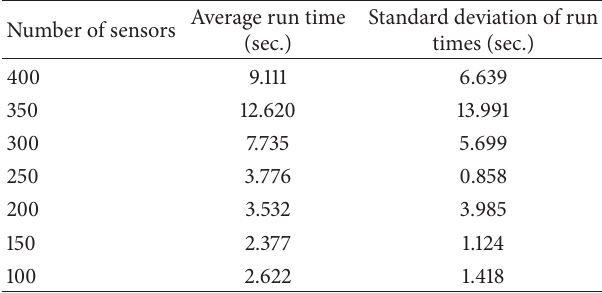
Table 8: Rankings of top 5 sensors based on volatility reduction in production costs (KPI-2).